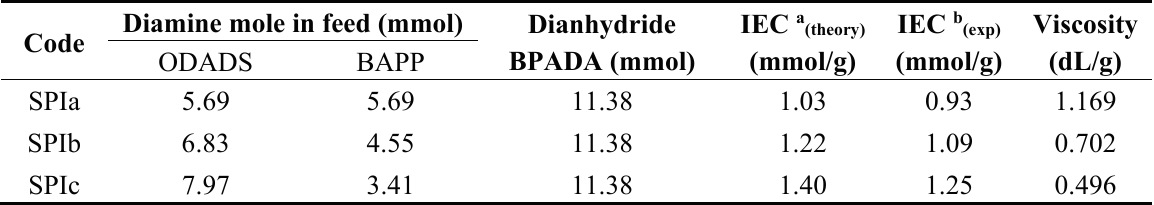
Table 1. The codes and mole fractions in the feed of various sulfonated polyimides; SPI, sulfonated polyimide; ODADS, 4,4'-diamino diphenyl ether-2,2'-disulfonic acid; BAPP,